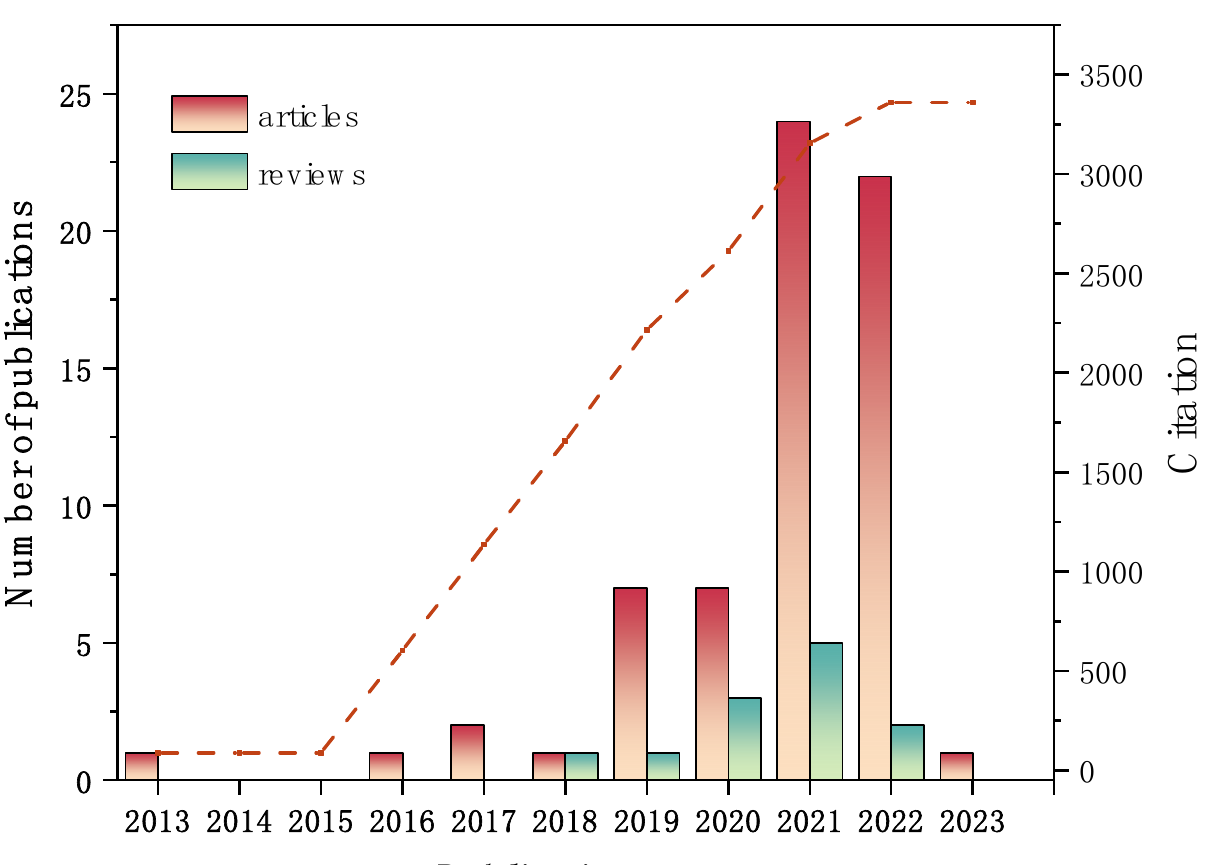
Figure 3. Annual number of publications and citation trends (red dashed line) for research on micro(nano)plastic toxicity to earthworms.